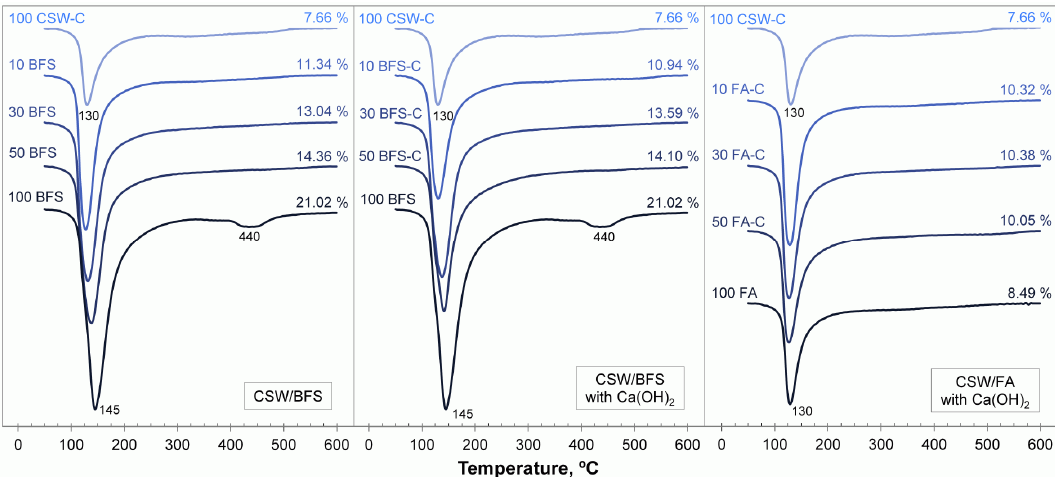
Figure 10. The differential thermogravimetric curves for the alkali-activated CSW blended pastes cured at 20 °C for 90 days. Total mass loss is indicated as a percentage.